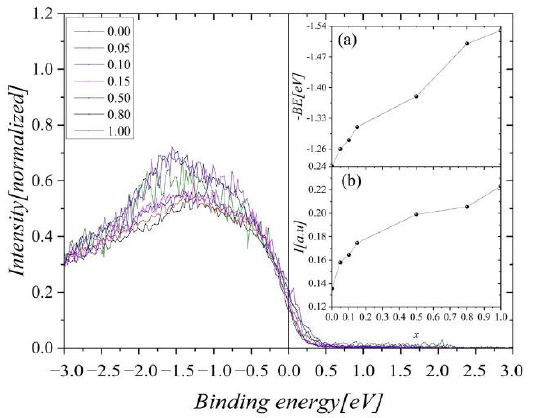
Figure 13. The XPS valence band of Gd 0.4 Tb 0.6 (Co 1x Ni x ) 2 near the Fermi level. Inset ( a ) shows the position of the maximum of 3 d states contribution and inset ( b ) presents the intensity at the Fermi level, both as a function of Ni concentration.